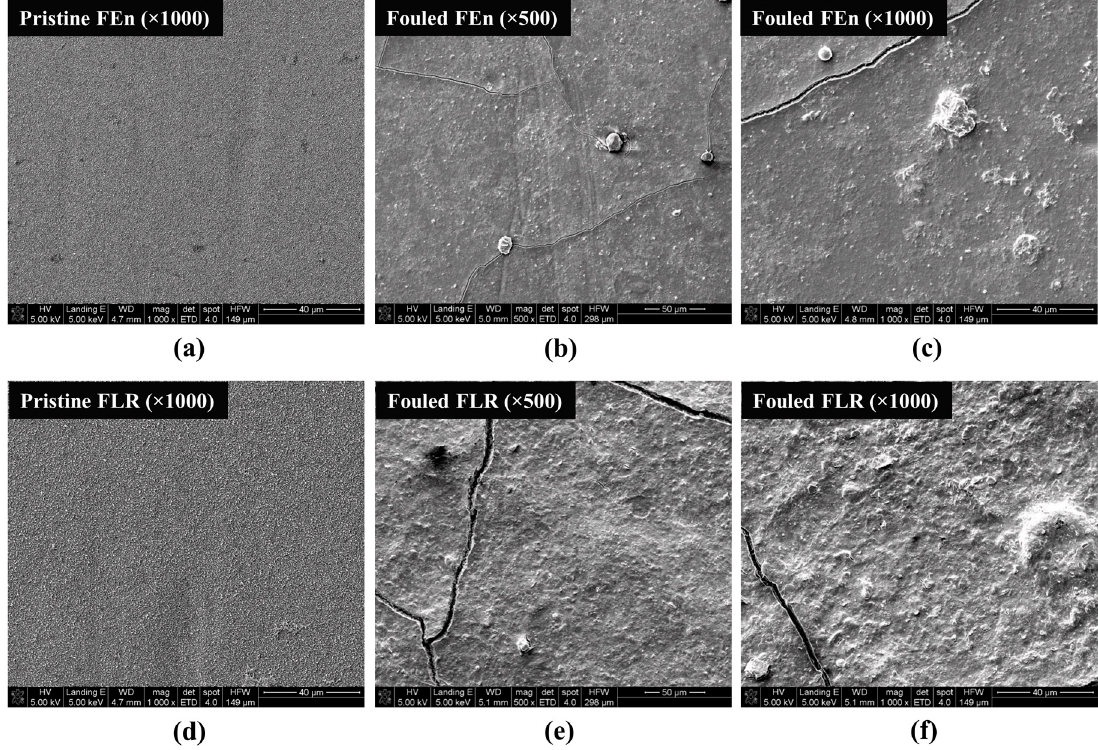
Figure 11. SEM images of the fouled and pristine membranes: ( a ) Pristine FEn ( × 1000); ( b ) Fouled FEn ( × 500); ( c ) Fouled FEn ( × 1000); ( d ) Pristine FLR ( × 1000); ( e ) Fouled FLR ( × 500); ( f ) Fouled FLR ( × 1000).